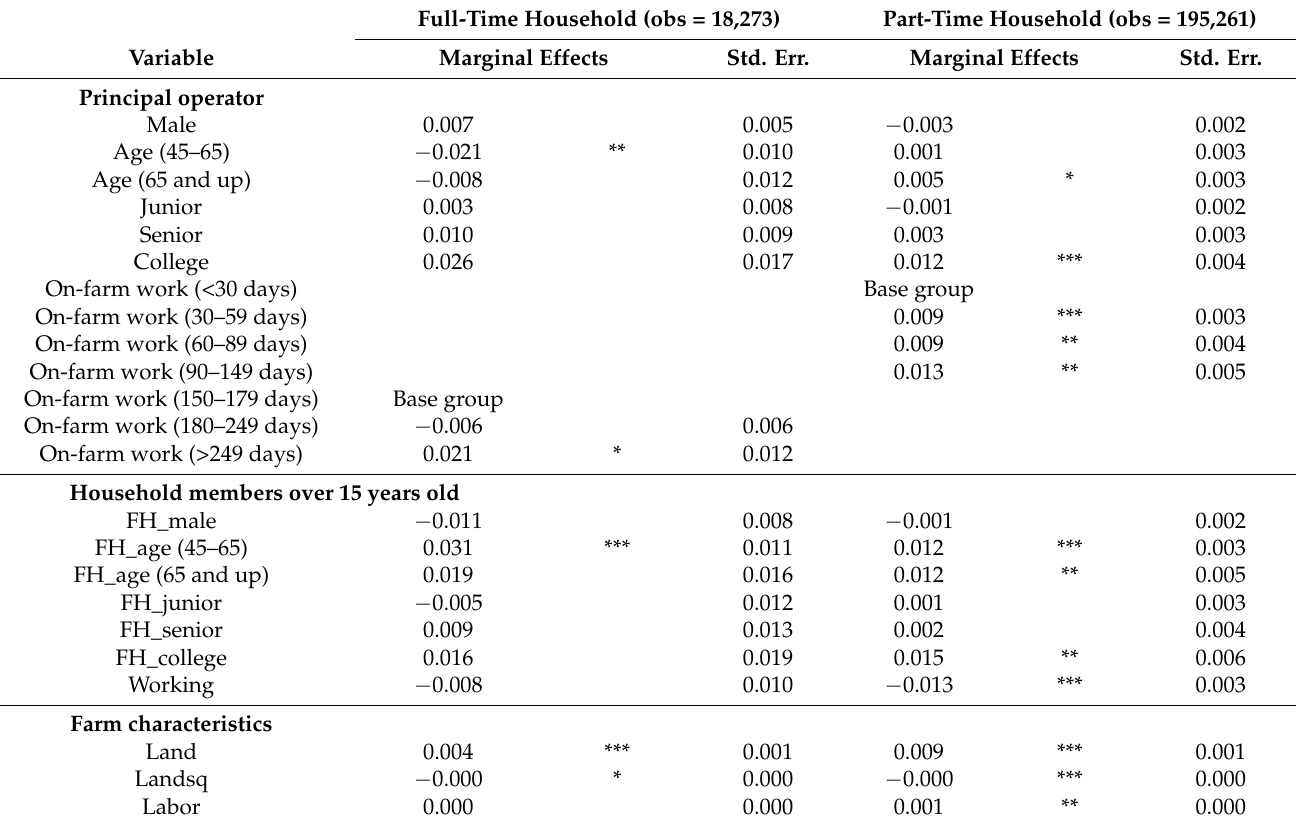
Table 3. Probit estimation of full- and part- time